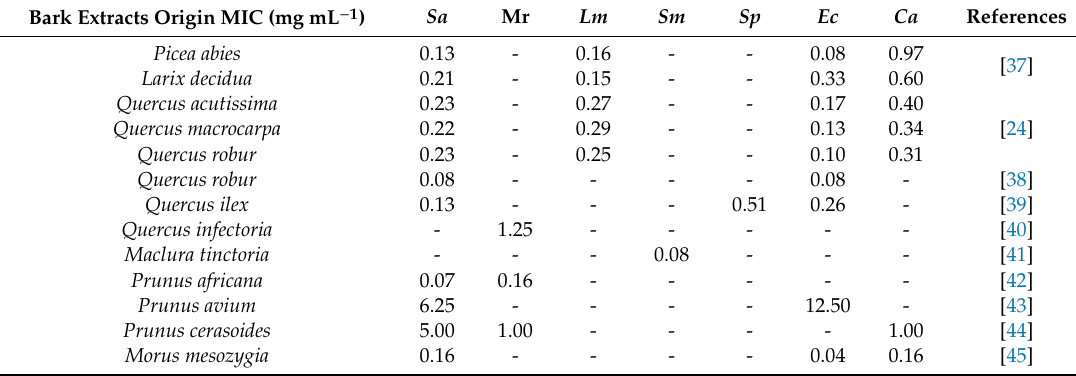
Table 4. Summarized MICs values for other waste extracts obtained from literature